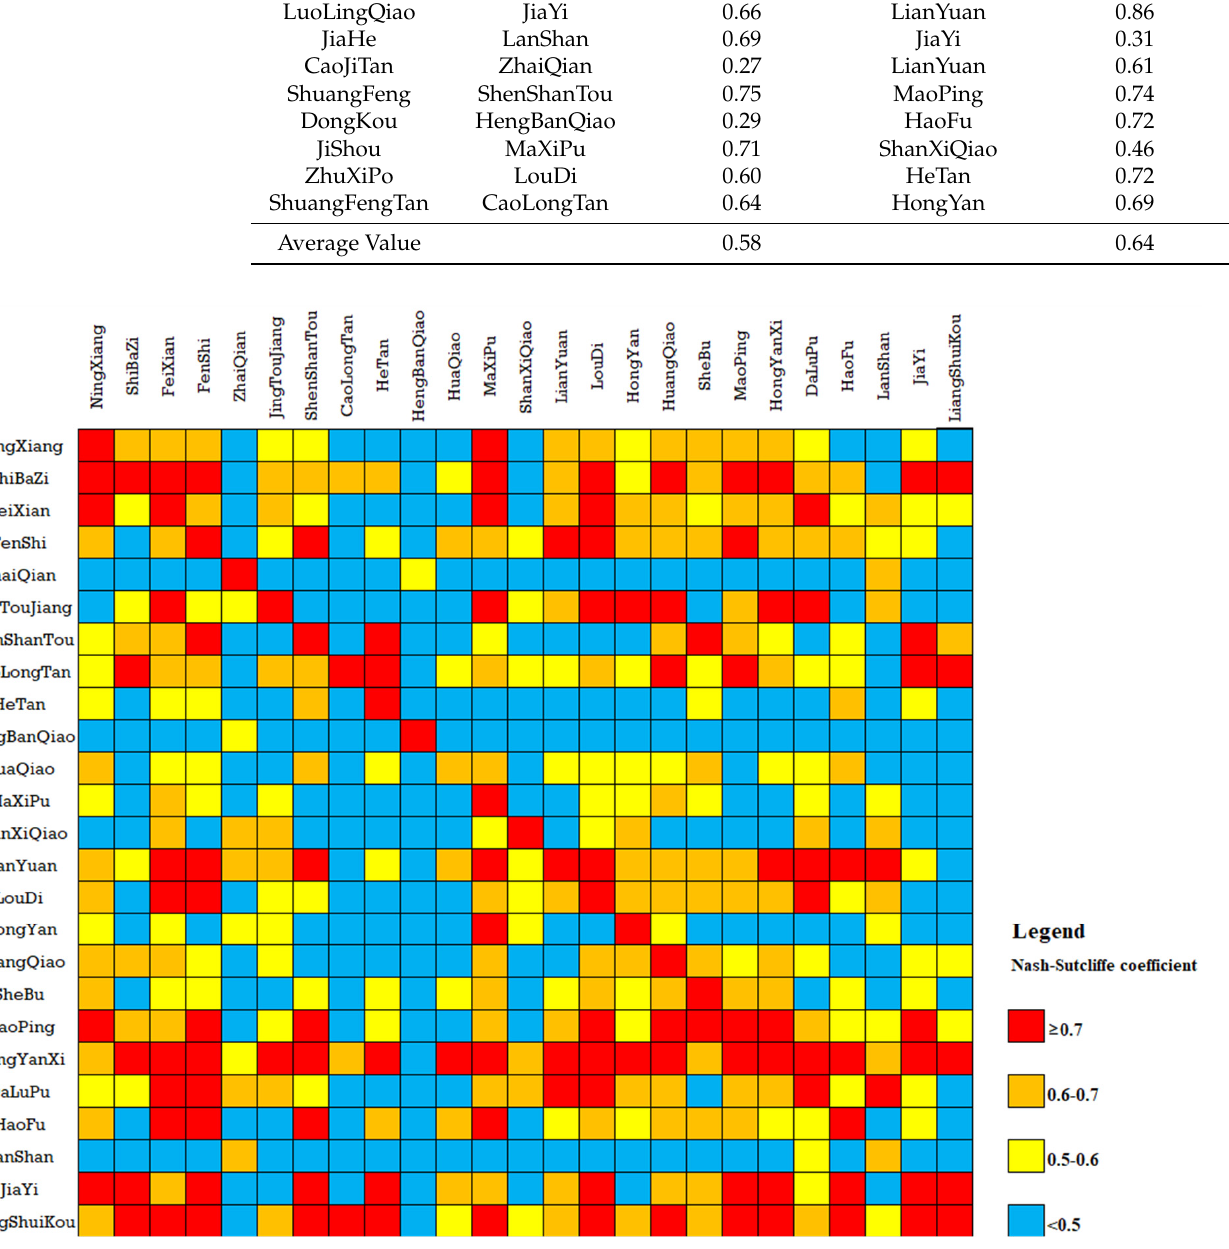
Figure 7. Cross validation results of parameter transplantation. Table 7. Transplant results of machine learning methods.